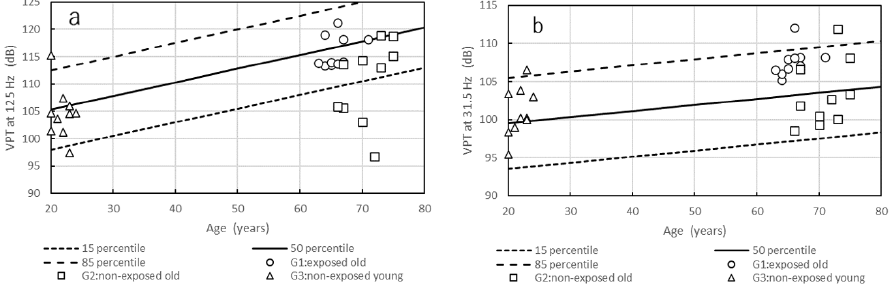
Figure 4. Baseline vibrotactile perception thresholds (VPTs) at frequencies of 125 Hz ( a ) and 31.5 Hz ( b ) measured prior to the experiments. Table 3. Mean baseline VPTs in the three subject groups.